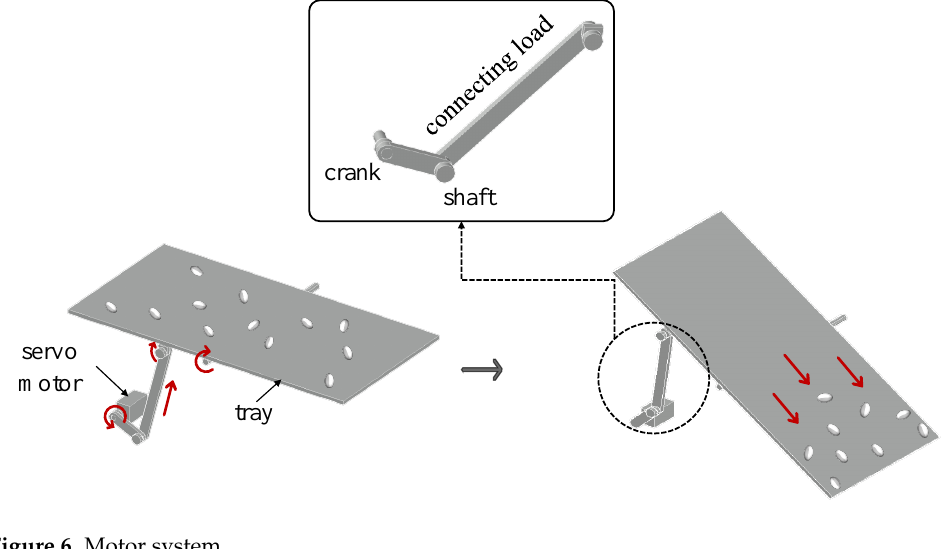
Figure 6. Motor system.